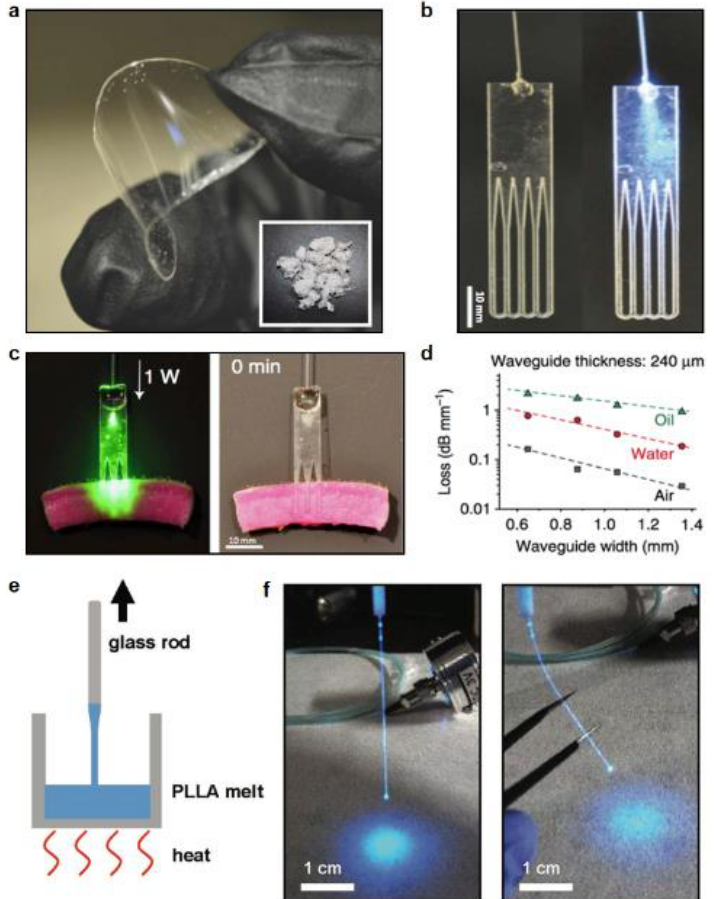
Figure 5. Fibers and waveguides made of biodegradable synthetic polymers. ( a ) A transparent, flexible PLLA film. Reproduced with permission [68]. Copyright 2016, Nature Publishing